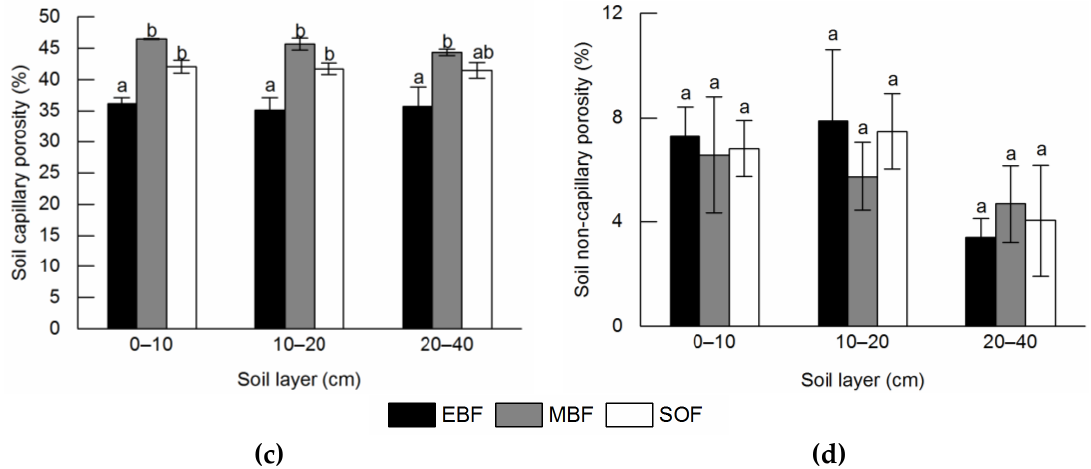
Figure 3. Soil water conservation in three forest types at different depths. ( a ) Soil water content; ( b ) soil total porosity; ( c ) soil capillary porosity; ( d ) soil non-capillary porosity. Different lowercase letters (a, b) above each bar indicate significant differences among different forest types ( p < 0.05), the same letters indicate no significant differences between each other, and two repeated letters (ab) indicate that the forest type is not significantly different from the other two types. Vertical bars show ± S.E.